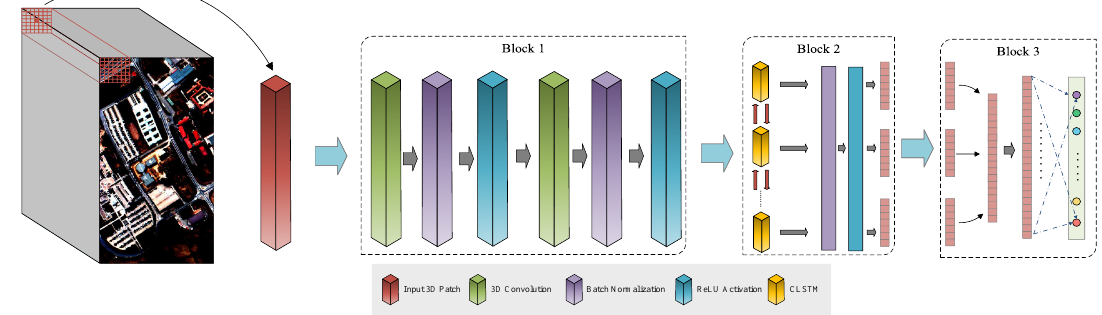
Figure 1. The framework of the proposed model for Hyperspectral imagery (HSI)